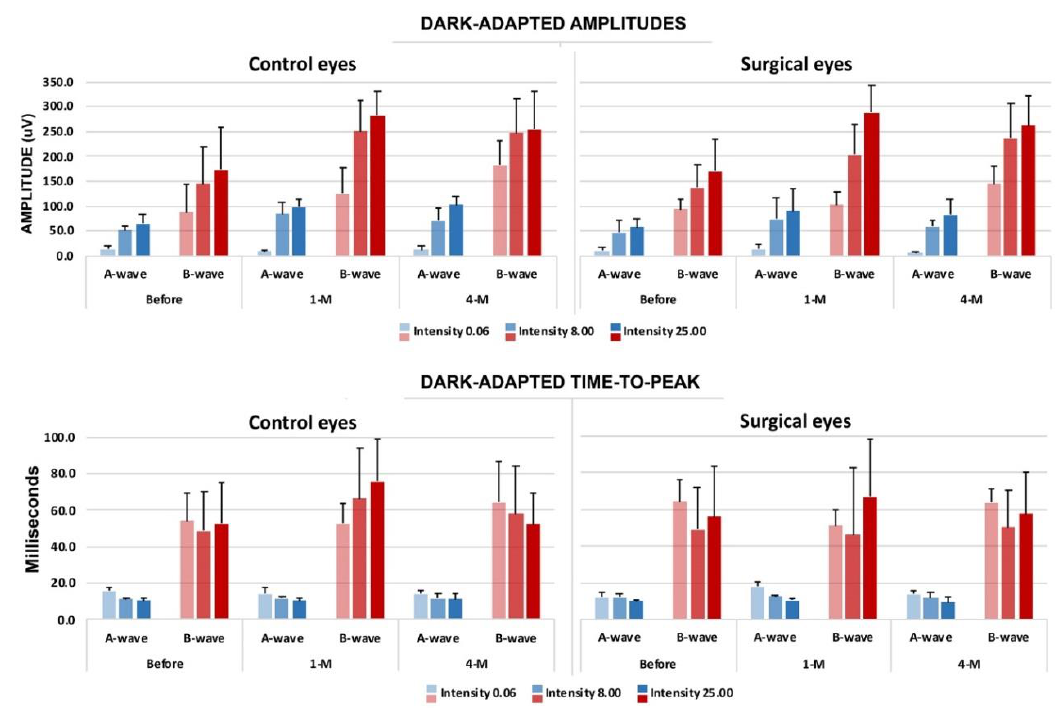
Figure 5. Evaluation results of electroretinography (ERG) with the time course compared to the surgical and non-surgical eye (negative control). Upper panel: dark-adapted amplitudes in both a- and b-waves. Lower panel: dark-adapted time-to-peak, both a- and b-waves. The blue bars indicate the a-wave, and the red bars indicate the b-wave. (n = 5.).